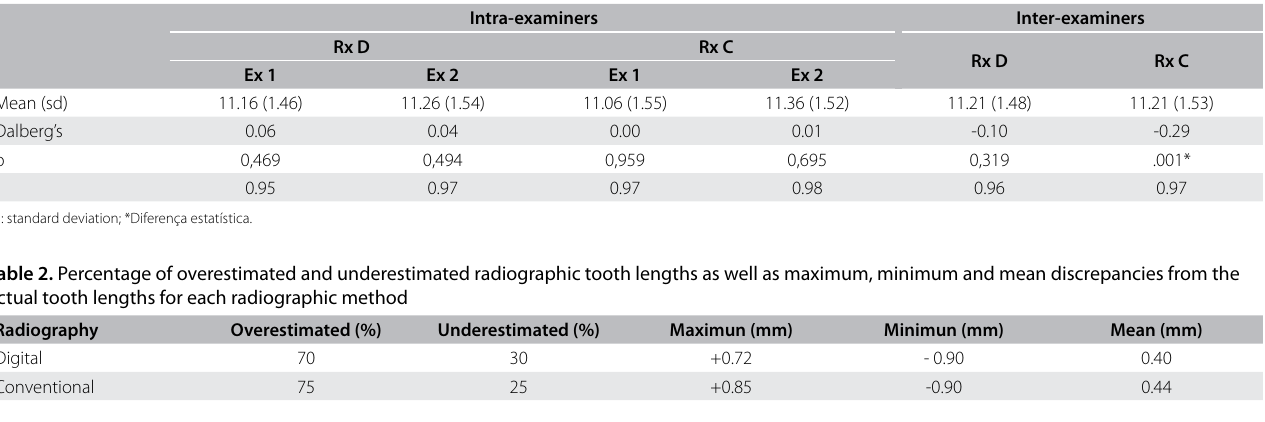
discrepancy, 60% of the measurements were considered accurate for both digital and conventional radiography. When the acceptable difference range was 1.0 mm, the accuracy of the radiographic mea- surements increased to